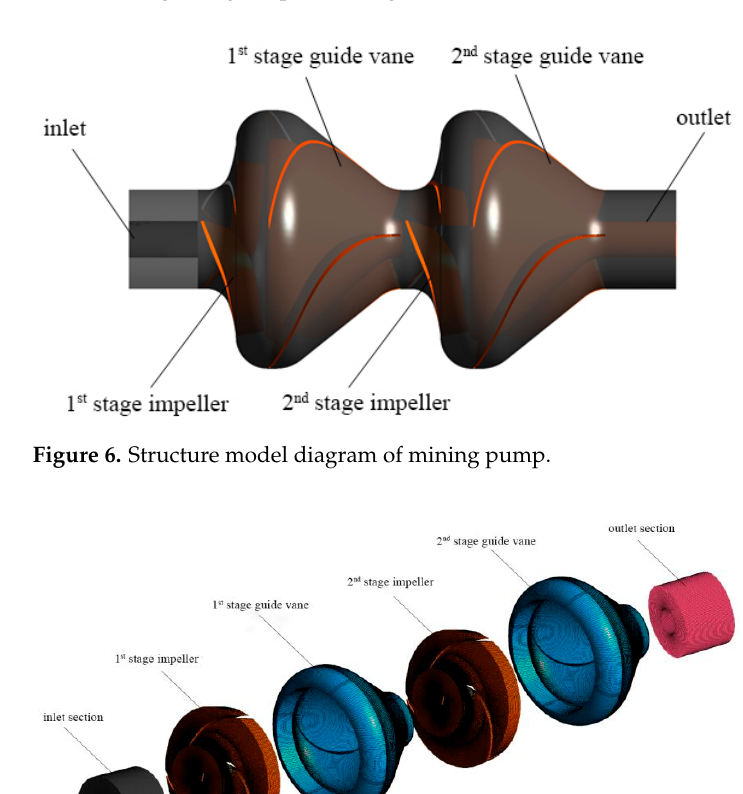
Figure 7. Model pump computational domain mesh.